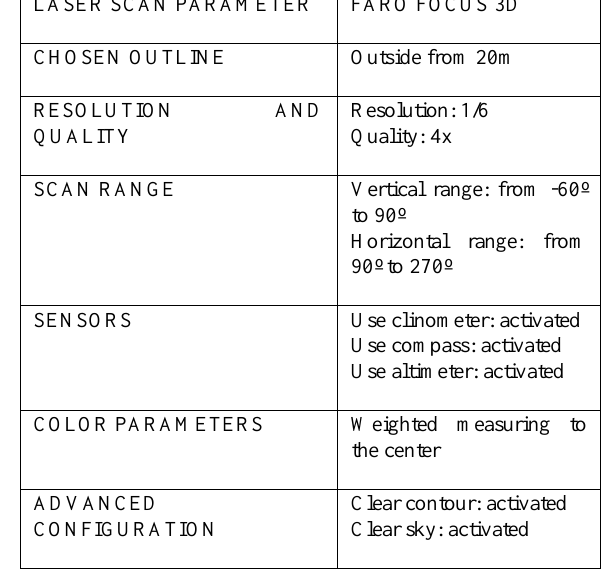
Table 1. Laser scan parameter Different positions were proposed for each part of the outside of the facade. Positions with the most seen surface of the building were searched, so that, the vertical scan range was always the maximum, from -60º to 90º, but the horizontal range was reduced, from 90º to 270º, due to the fact that the new angle didn’t need to be as much larger as the first one because it was only one plan.